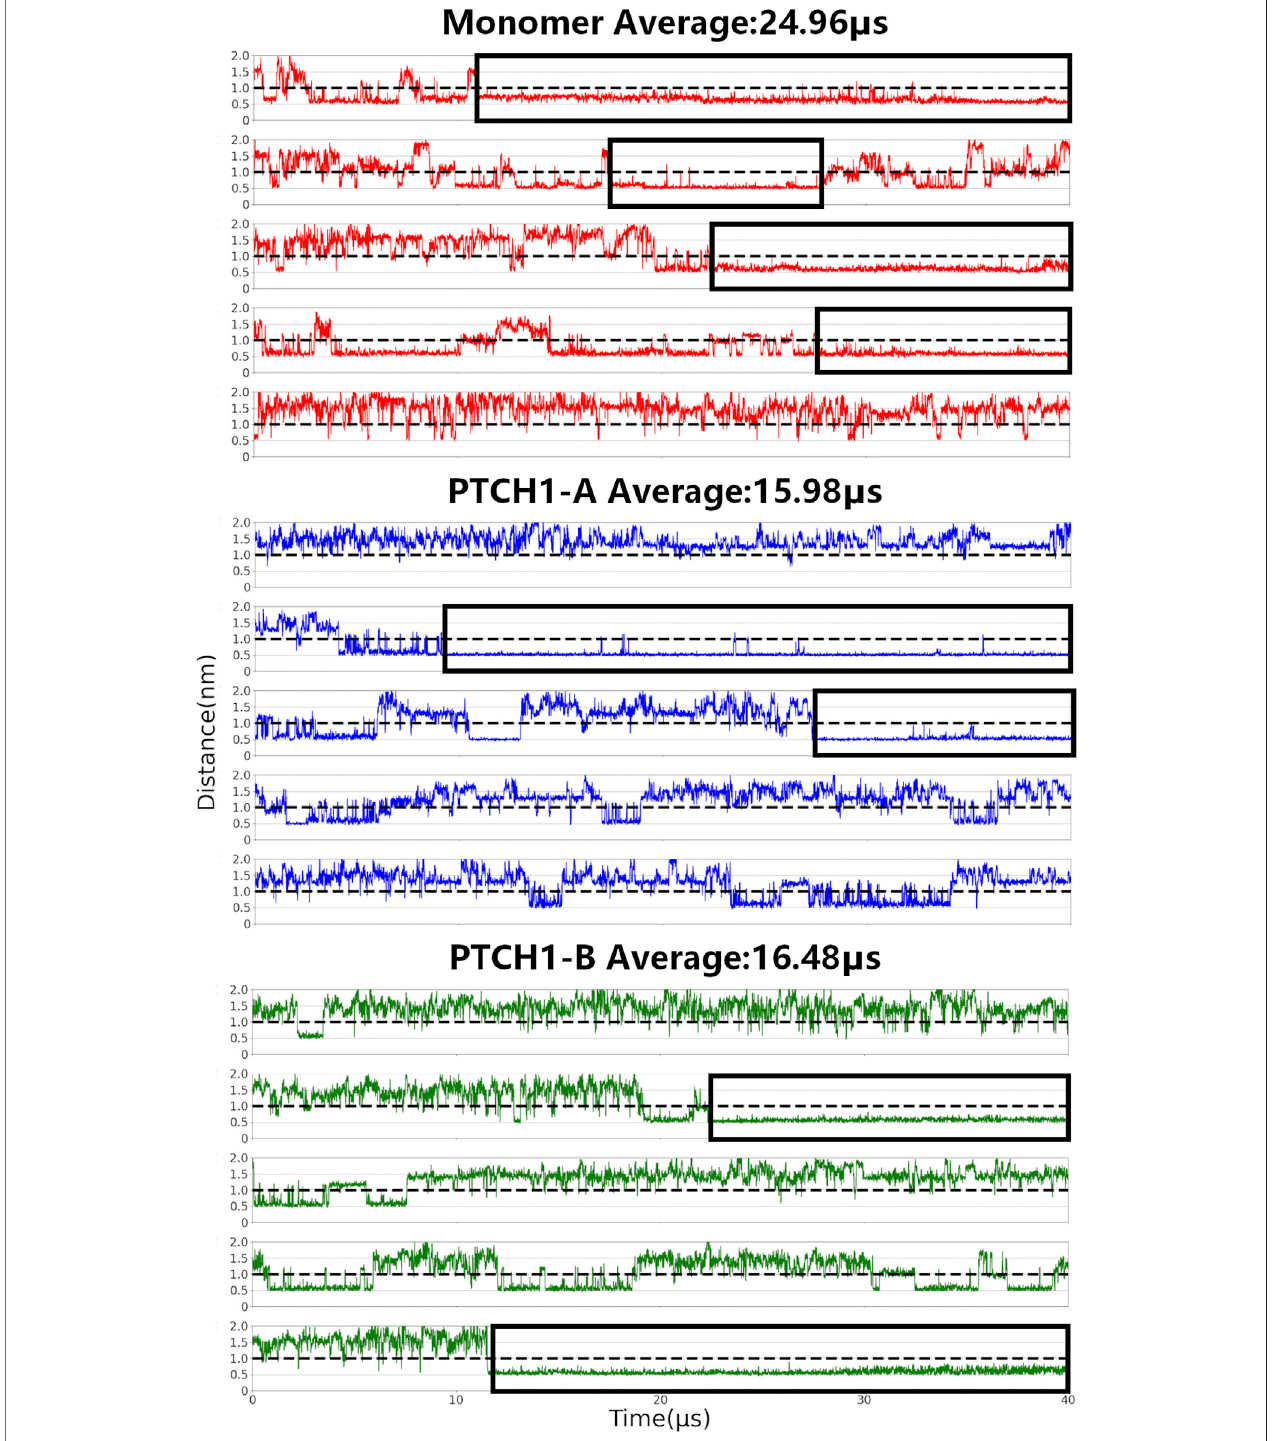
FIGURE2| CHOLbindingtotheSSD.Center-of-massdistancesbetweenP504anditsnearestCHOLROHbeadwerecalculatedforallsimulationsofthePTCH1 monomer and dimer-Shh (PTCH1-A and PTCH1-B) systems.